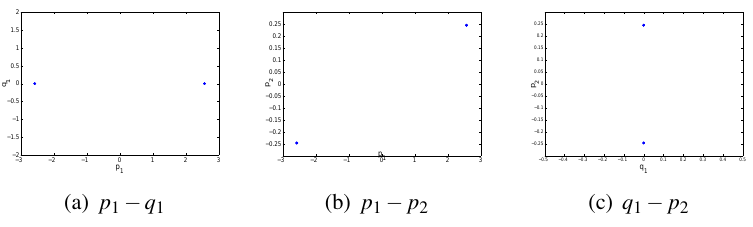
Fig. 9 Section of global random basic attractors for ϕ NGM 3 with case IV